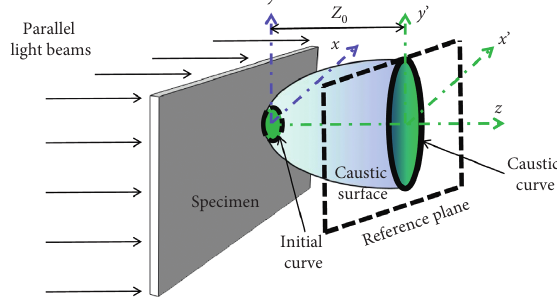
Figure 1: Caustic